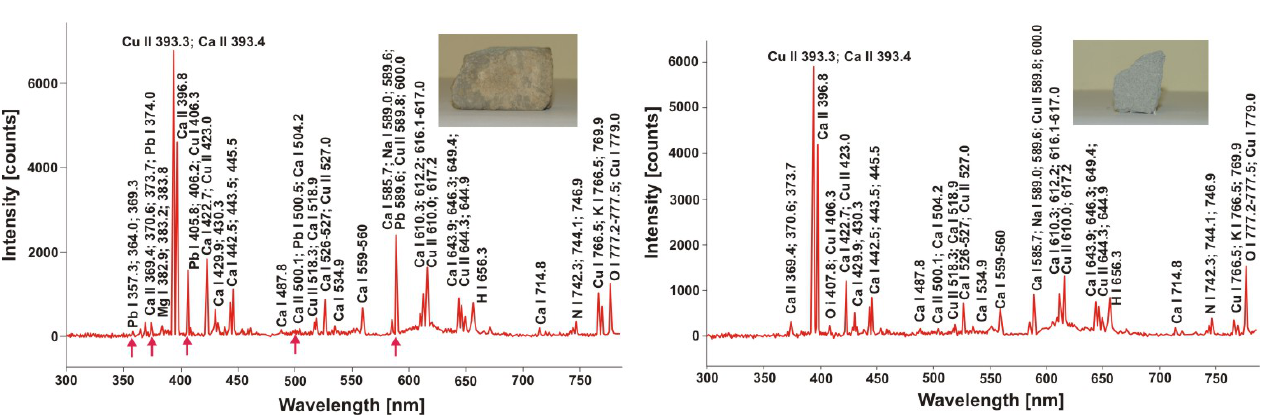
Figure 11. LIBS spectra of My ś lenicki sandstone from Sigismund Chapel, Cracow. a) encrustation with lead lines (red arrows); b) “fresh” sandstone